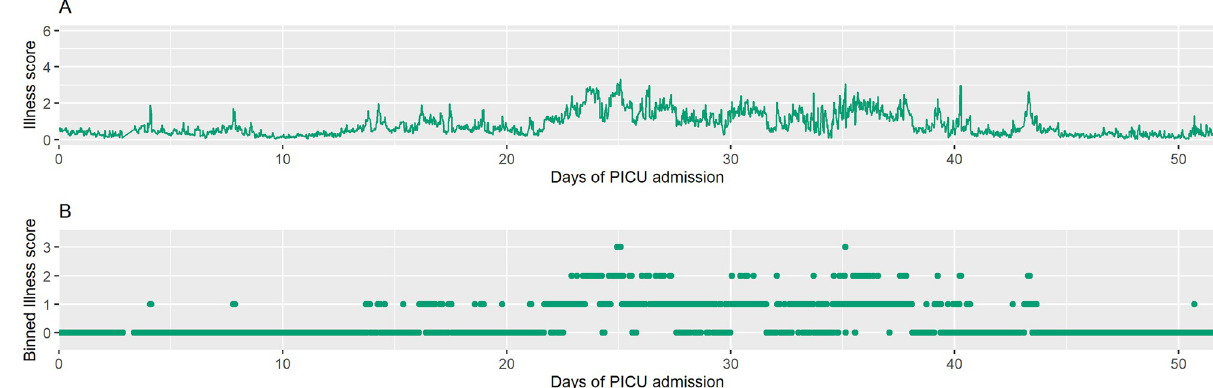
Fig 3. Time series of illness scores for patient 1. (A) Raw time series of illness scores for patient 1. (B) Time series with illness states sampled every 30 minutes and binned to create 4 discrete illness states (0–3). Patient 1 had 2,441 observed illness states, measured every 30 minutes, over a 51-day